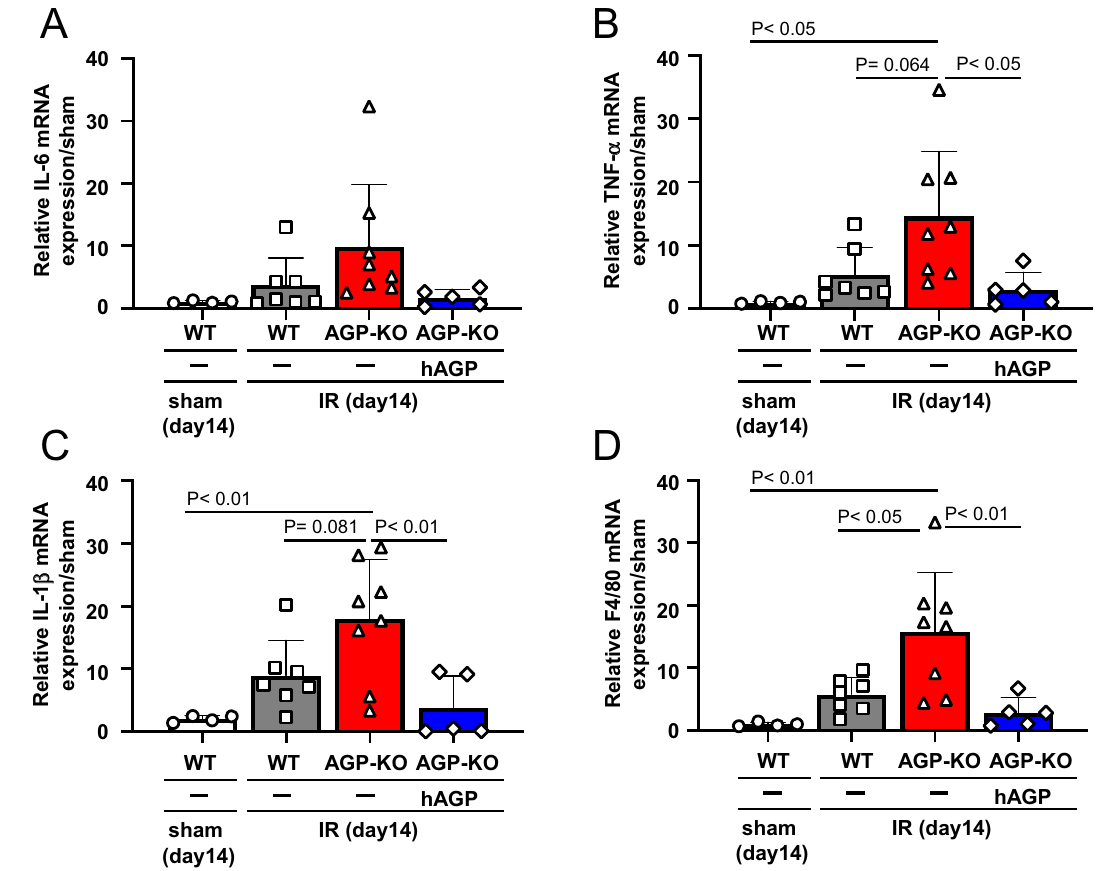
Figure 5. Administration of hAGP rescues renal inflammation at day 14 after renal-IR in AGP KO mice. The mRNA expression of ( A ) IL-6, ( B ) TNF-α, ( C ) IL-1β and ( D ) F4/80 in the kidney at day 14 after renal IR were determined by real-time PCR. hAGP administration to AGP KO mice (2 mg/mouse/day, ip , from day 0 (before IR) to day 7) suppressed IR-induced renal inflammation. Data are expressed as the means ± SE (n = 4–8).